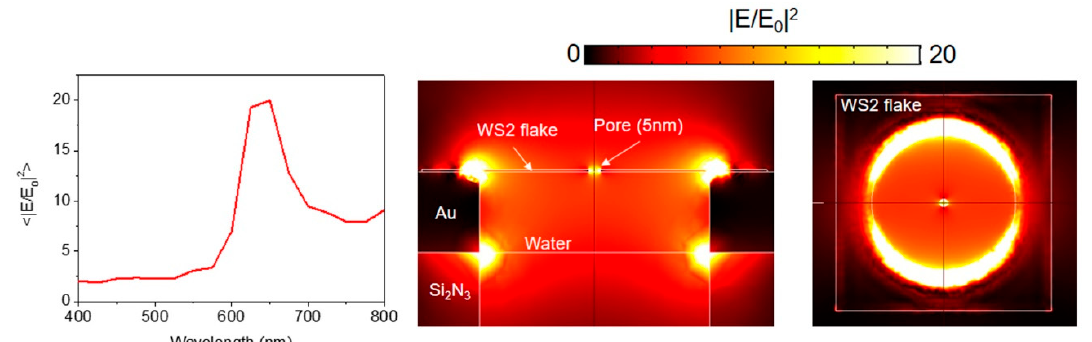
Figure 9. Finite element method (FEM) simulations of the investigated structures covered with one mono-layer of WS 2 (simulations performed at excitation wavelength 633 nm).